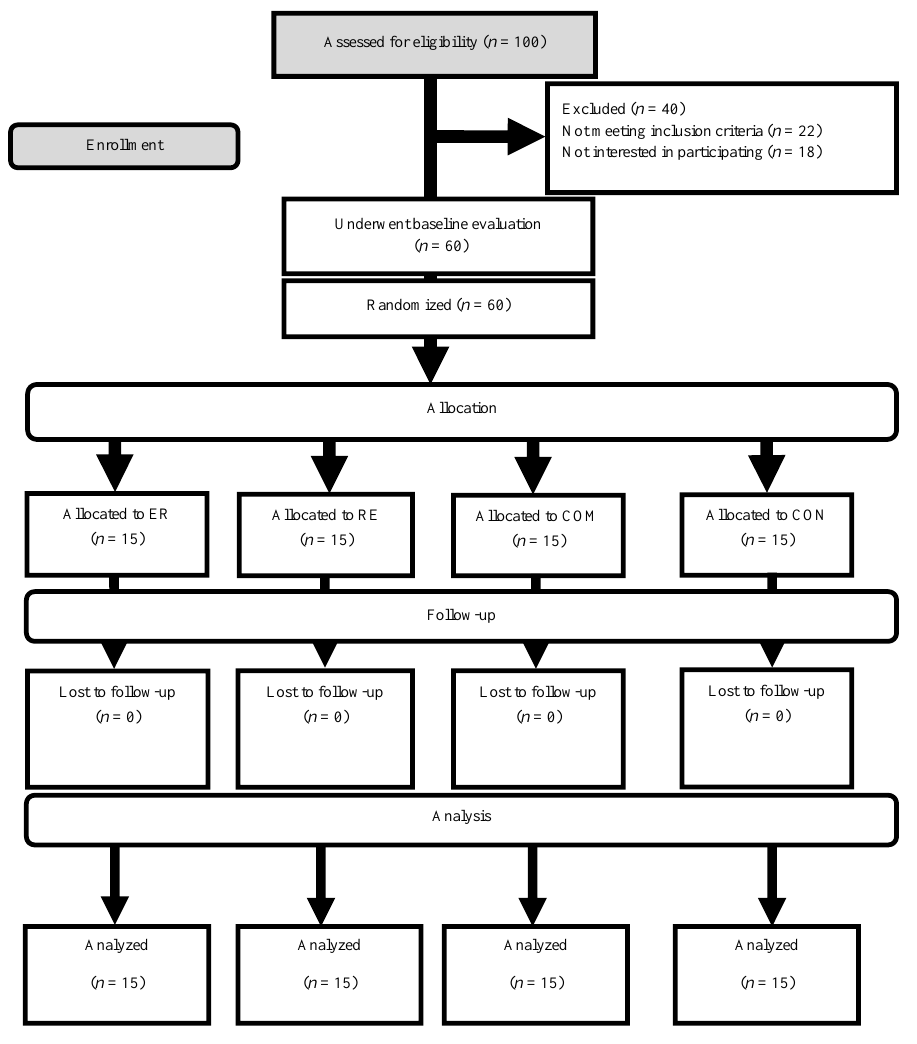
Figure 1. Flow of participant recruitment.